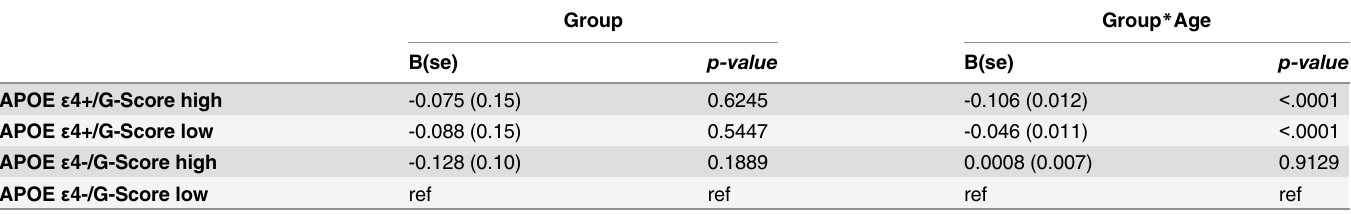
Table 2. Mixed Effects Models for Cognitive Decline by APOE /G-score group.